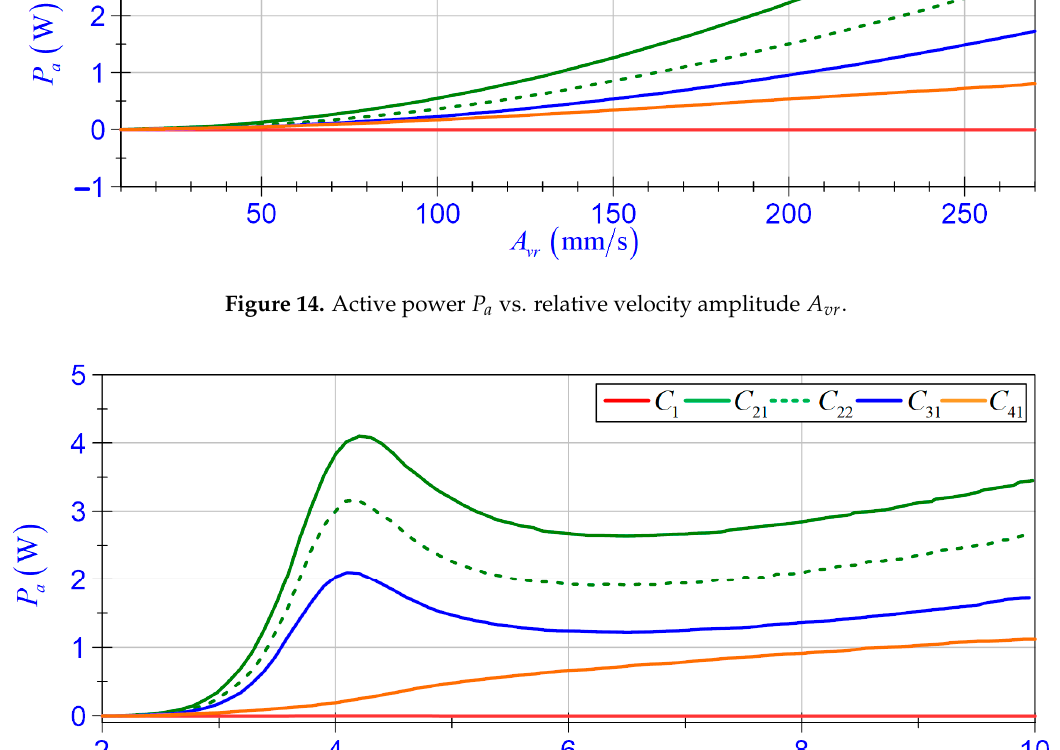
Figure 16. Vibration reduction system with MR damper using self-sensing and self-powered ac- tion.